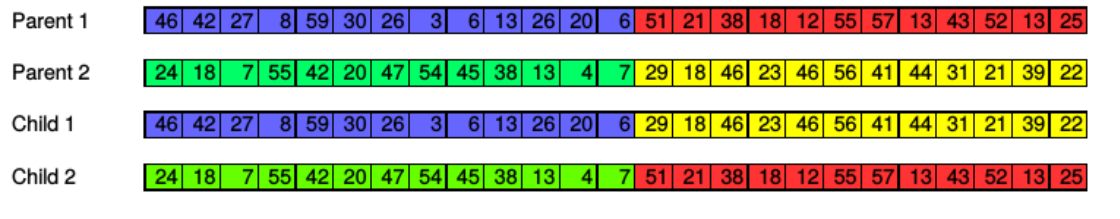
Figure 4. Example of crossover operation.